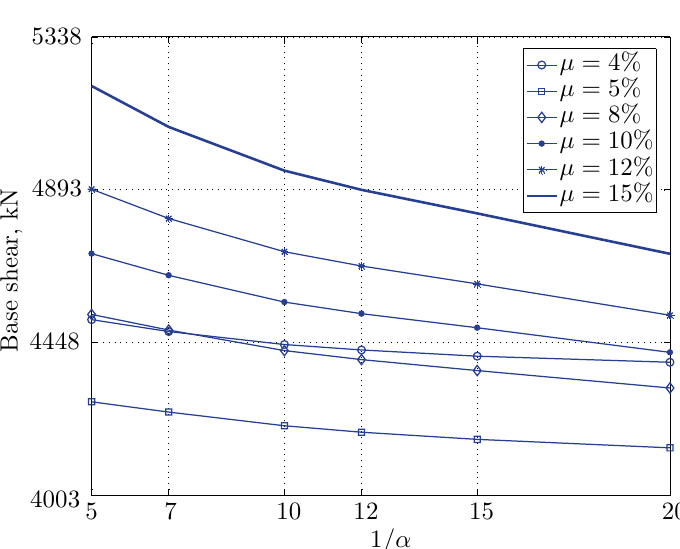
Figure 35. Maximum base shear for various isolation system parameters